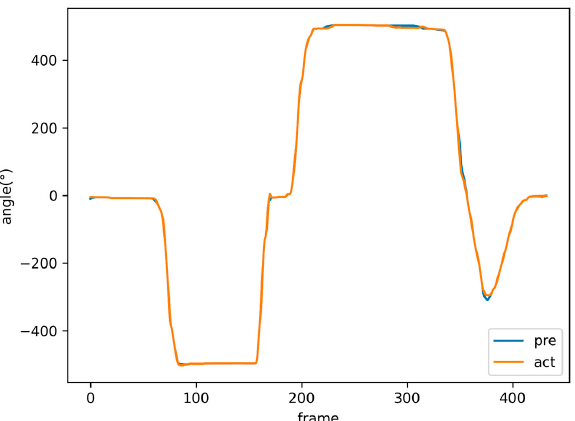
Figure 12. Steering wheel turning angle curve predicted by CNN-LSTM model.